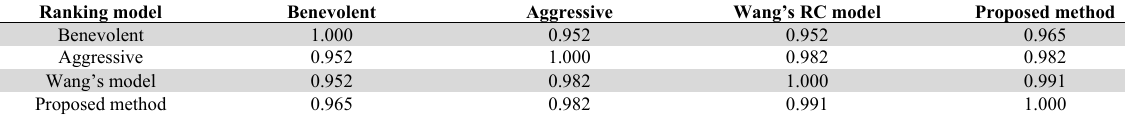
Spearman’s rank correlation test for fourteen international passenger airlines Ranking model